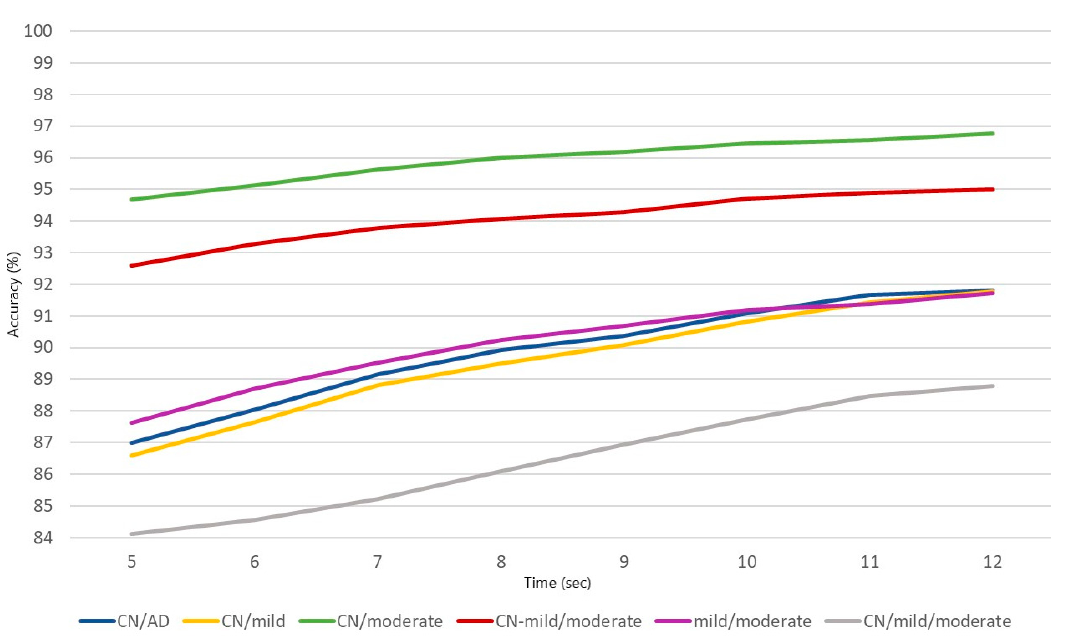
Table 3. The classification results in terms of the Accuracy (ACC) for each classification problem for 8 window lengths.